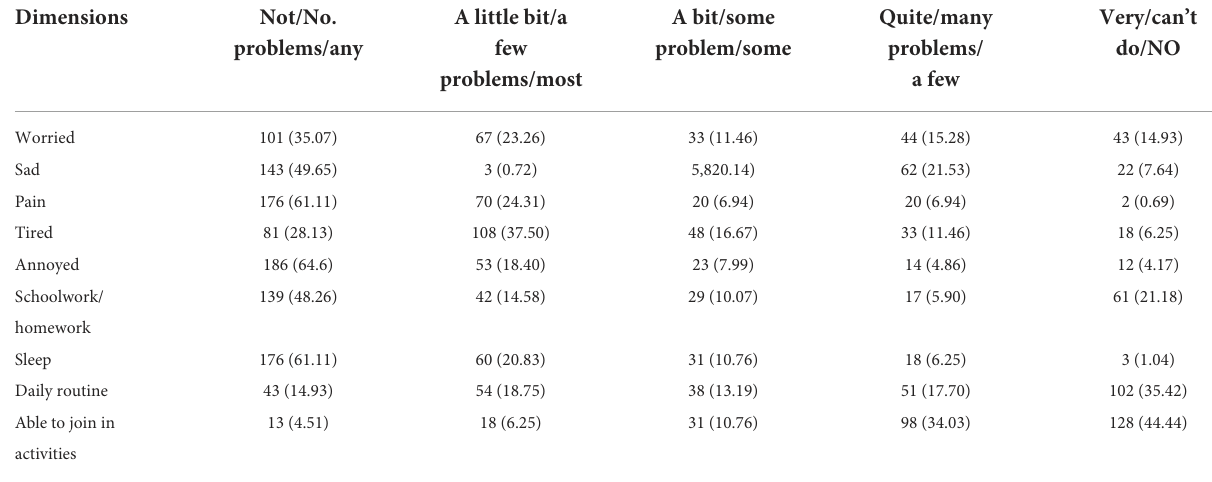
TABLE 4 Response frequencies (%) for the CHU9D ( N = 288).